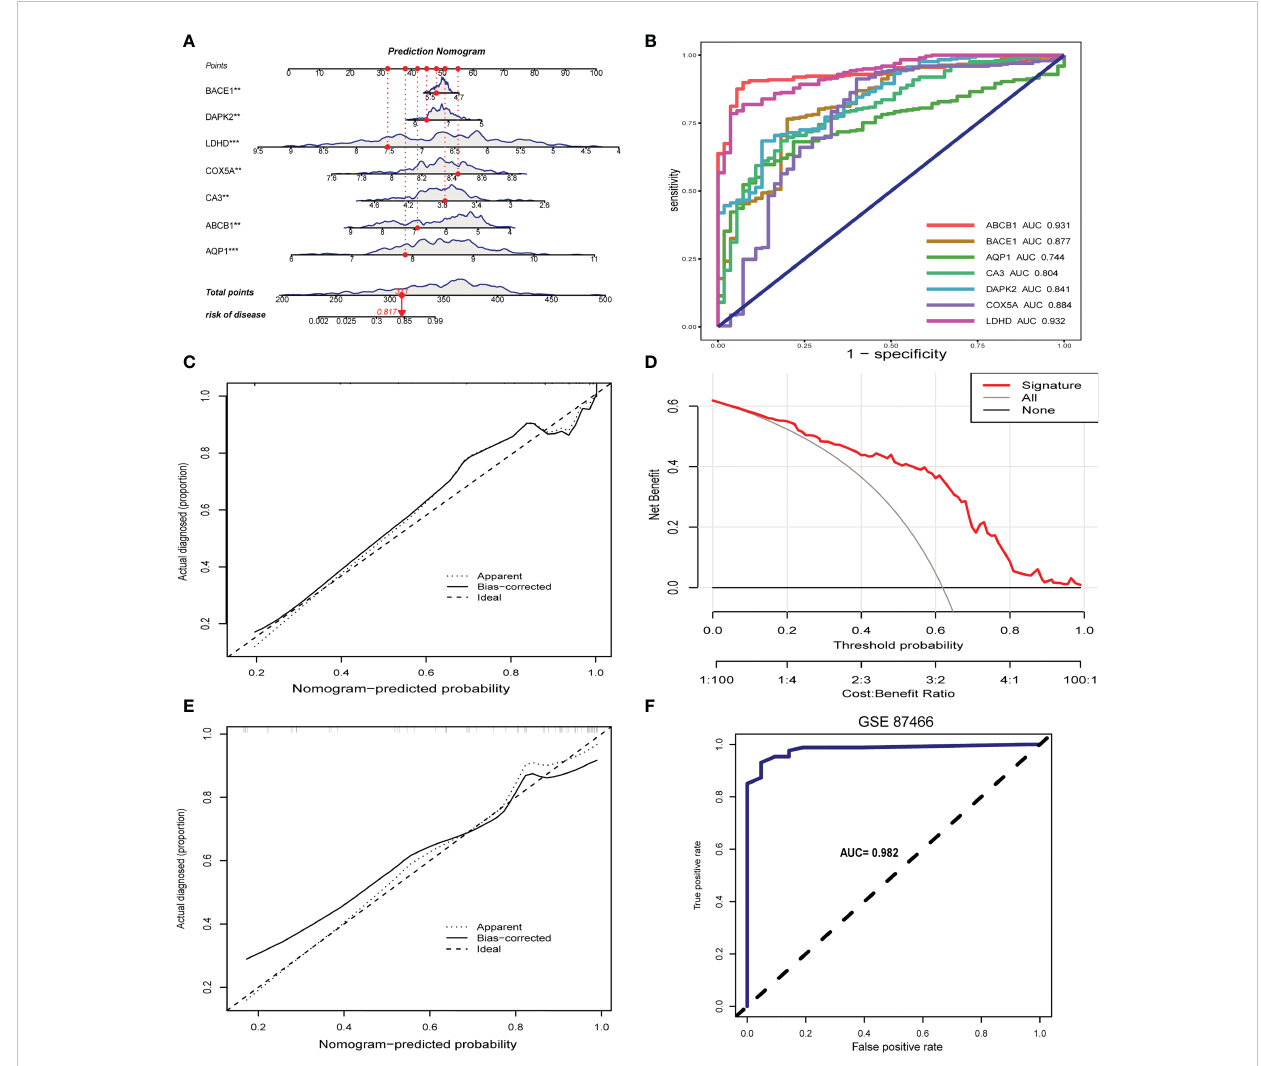
(E) Calibration curve of nomogram for predicting UC in the validation set. (F) ROC curve for the validation set. **p < 0.01, ***p <